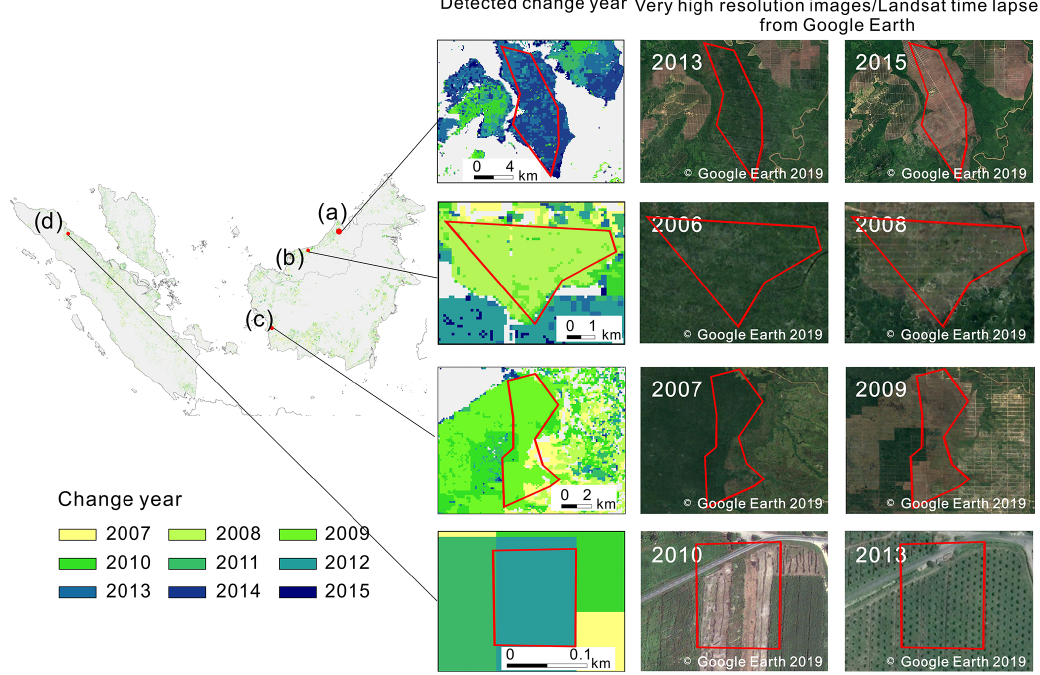
Figure 6. Visual comparison of the detected change years with the high-resolution images and medium-resolution Landsat images from Google Earth. The colour of the first column represents the change-detected time in our results. The red shape highlights the change areas. Panels (a) and (b) are two selected regions located in Sarawak, Malaysia. The Landsat images in the right indicate that the deforestation and plantations of oil palm occurred between 2013 and 2015 and 2006 and 2008, respectively, and the change times (2014 and 2008) were captured in the result maps. Panel (c) is an example of change detected in 2009 in West Kalimantan, Indonesia, where forest type is presented in the Landsat images in 2007 and oil palm plantations shown in 2009; (d) is a case showing the conversion of cropland to oil palm in North Sumatra, Indonesia, according to the high-resolution images from Google Earth. The young oil palm trees in the 2013 image indicate that the conversion may have occurred 1 or 2 years before, which matched the results in our maps (detected change time in